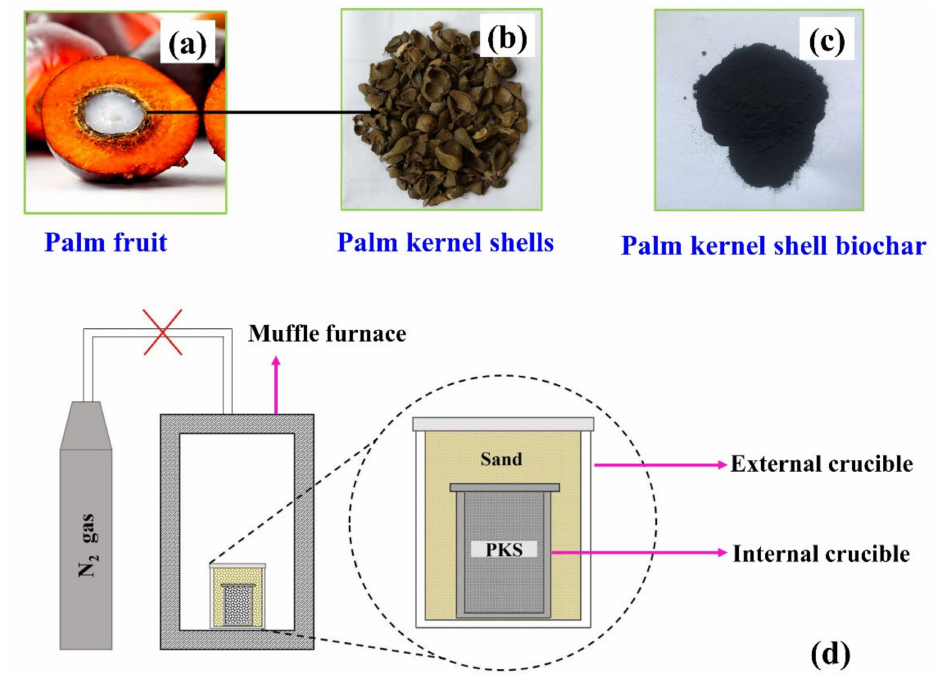
Figure 1. ( a ), ( b ), and ( c ) represent palm fruit, palm kernel shell (PKS), and palm kernel shell biochar (PKSBC), respectively. ( d ) Experimental configuration for biochar